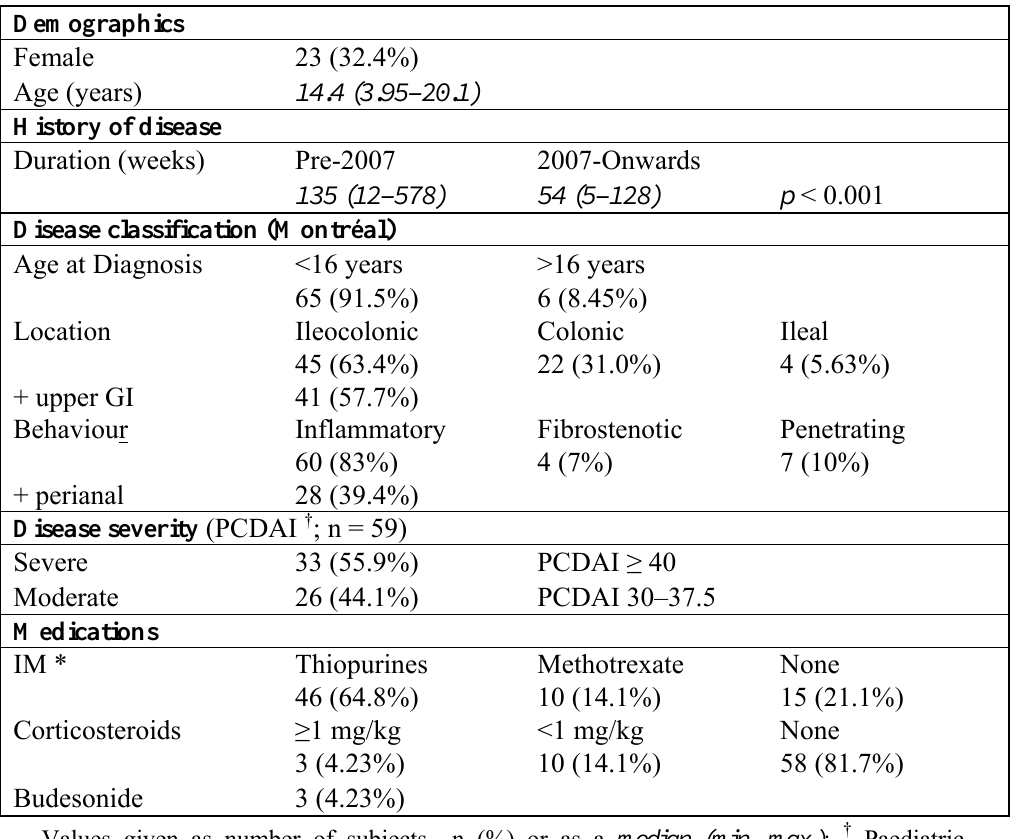
Table 1. Baseline